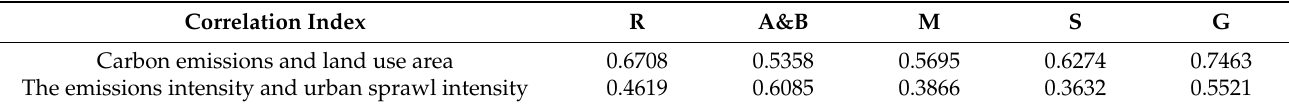
Table 3. Relational grades of carbon emissions with land use area and urban sprawl